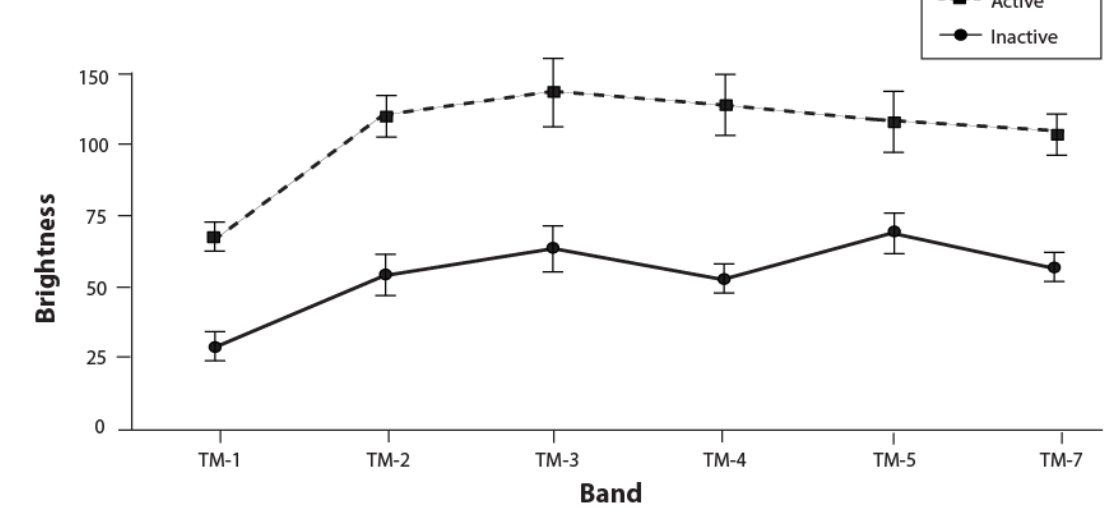
Figure 4. Zonal statistics: the spectral signatures of active and inactive dunes across a 24-year period (1982 to 2006). Error bars represent maximum and minimum, and data points represent average of the zones.